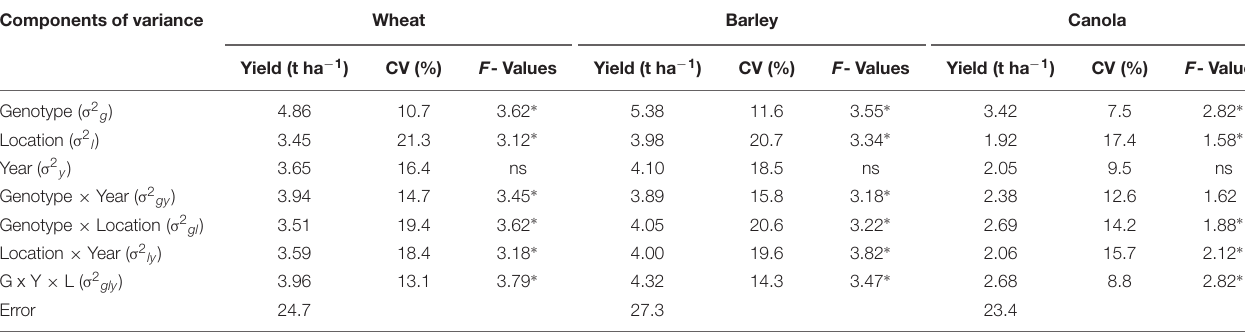
TABLE 5 | Estimates † of variance components for grain yield, genotypes, and their interactions with location and years under optimal nutrient management. Components of variance